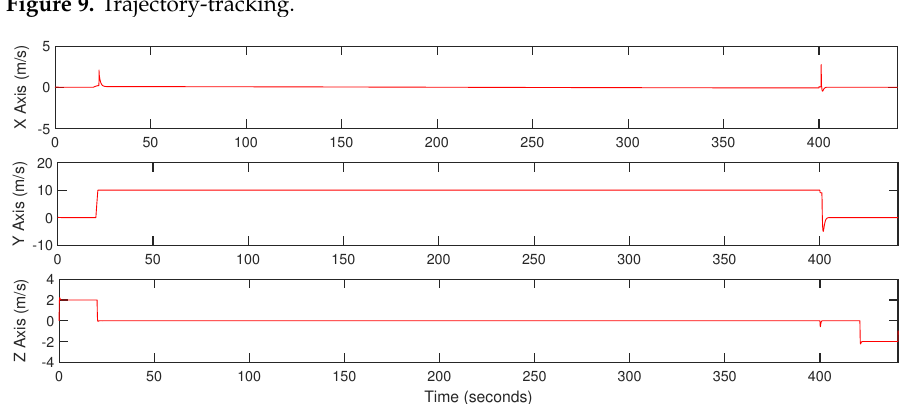
Figure 9. Trajectory-tracking.